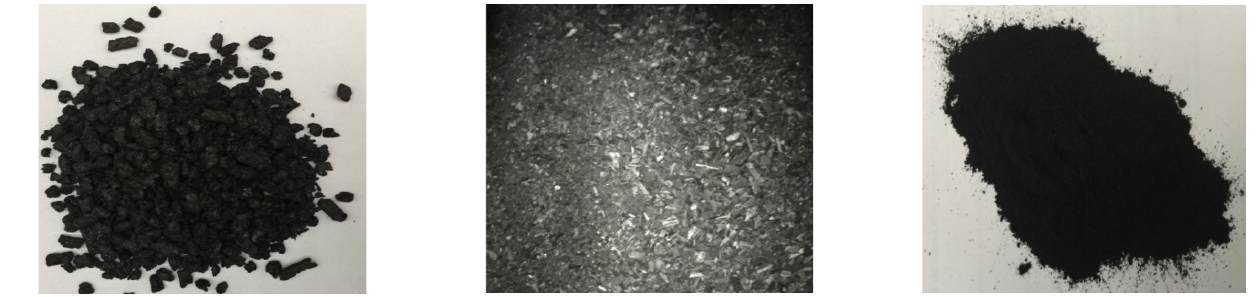
Figure 4. Chars derived from: ( Left )—pelletized sawmill sawdust (AGS = 3.37 mm), ( Middle )—wood chips (AGS = 1.26 mm), and ( Right )—sunflower husks (AGS = 0.28 mm).